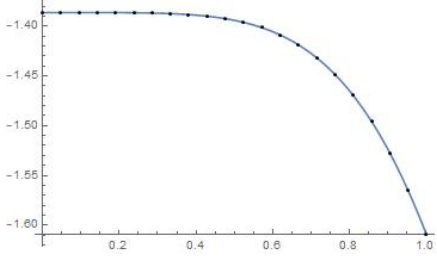
Figure 2. Exact solution of Example 2 and a discrete one for M =